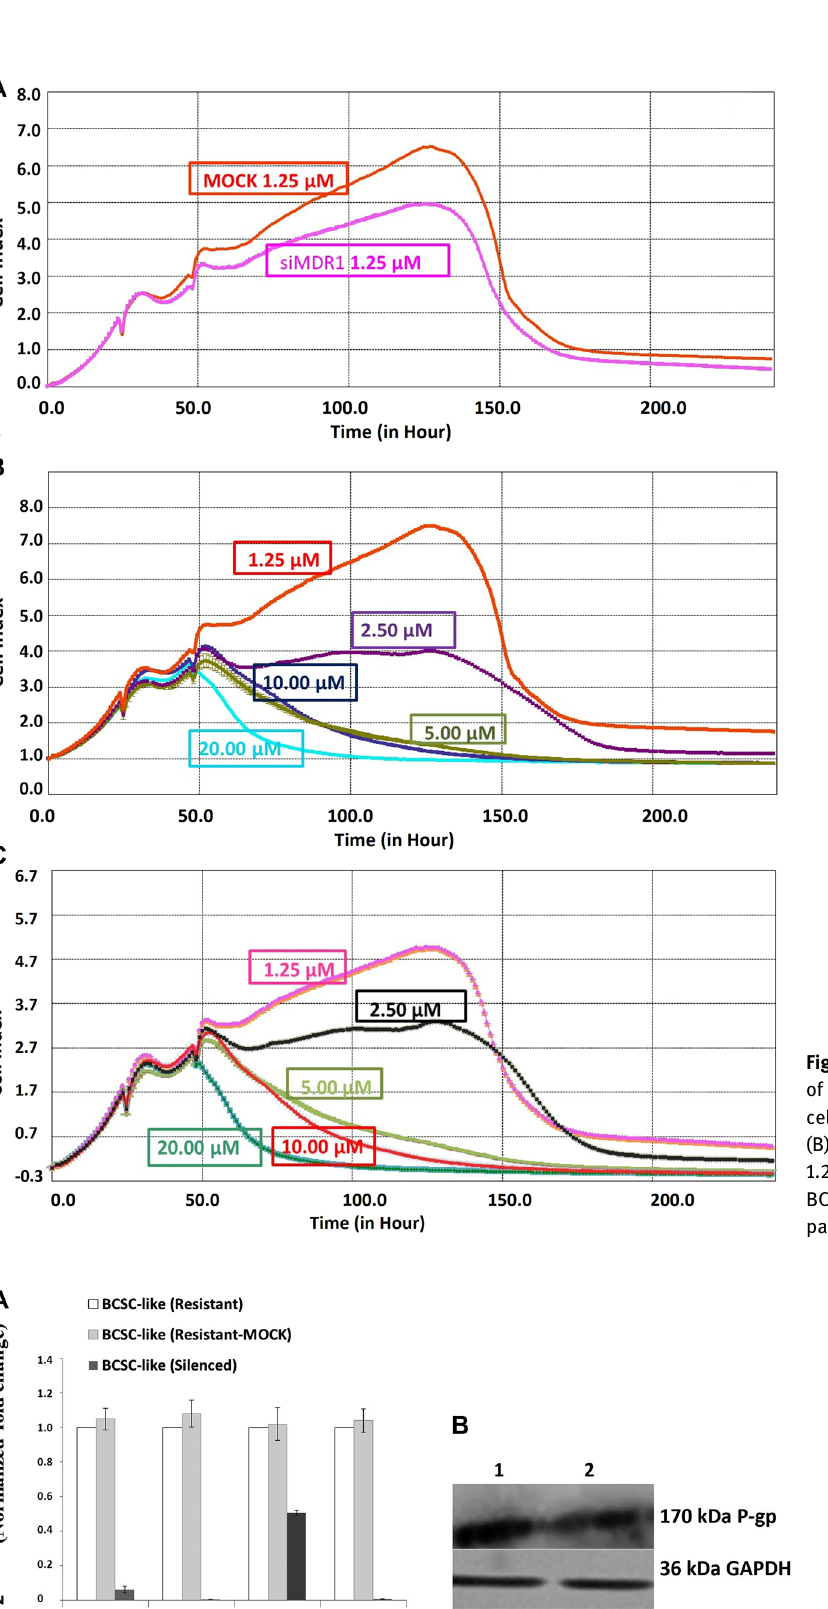
Figure 4: (A) results of gene expression analysis for MDR1 , ALDH1A3 , BAG4 and EGFR genes by 2 − ΔΔ CT method. (B) Western blot analysis for P-gp/GAPDH and densitometry values of the normalized membrane blot bands 1. BCSC-like (resistant) 2. BCSC-like